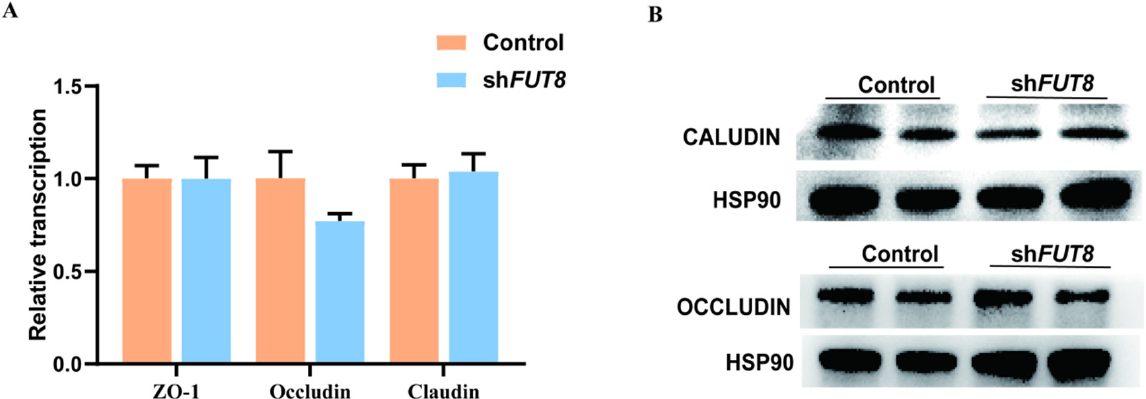
Figure 5. Effect of the FUT8 genes on the expression levels of tight junction genes. ( A ) qRT-PCR analysis of mRNA expression of tight junction protein in FUT8 -knockdown IPEC-J2 cells. ( B ) Western blot analysis of protein expression of tight junction genes in FUT8 -knockdown IPEC-J2 cells. HSP90 was used as an internal reference.